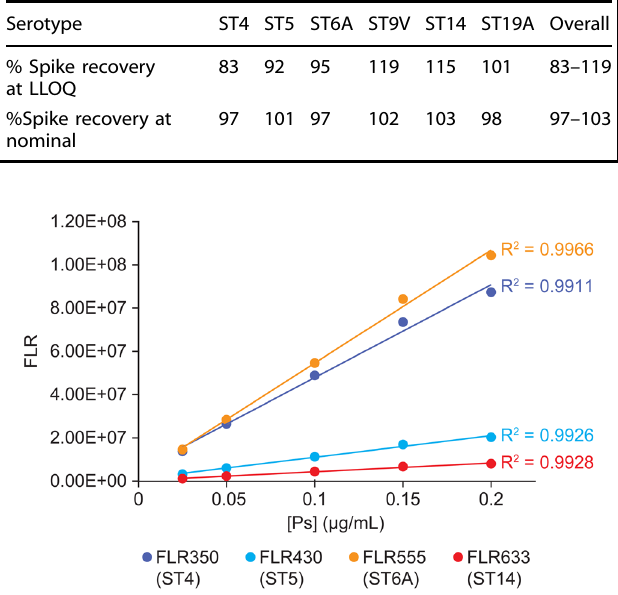
Fig. 7 Overlay of standard curves from multiplexing fl uorescence (FLR)-tagged mAbs with a multivalent PCV standard. The four standard curves were generated in a single HPLC run by simultaneous detections on four fl uorescence channels.